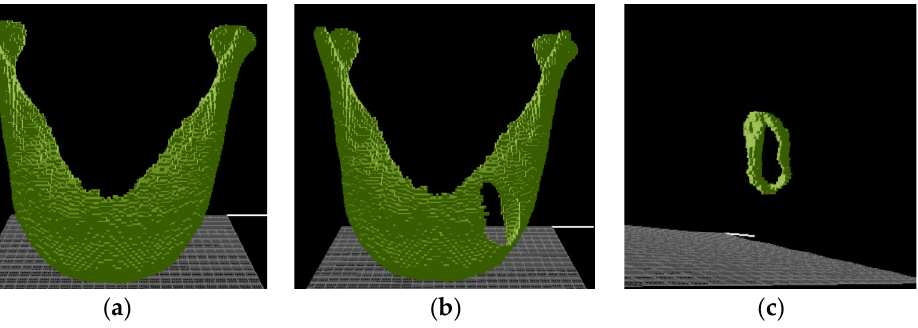
Figure 6. Three-dimensional model with dimensions of 128 × 128 × 128. ( a ) Voxelized 3D model ( b ) Simulated 3D model of defect ( c ) Implant 3D model.